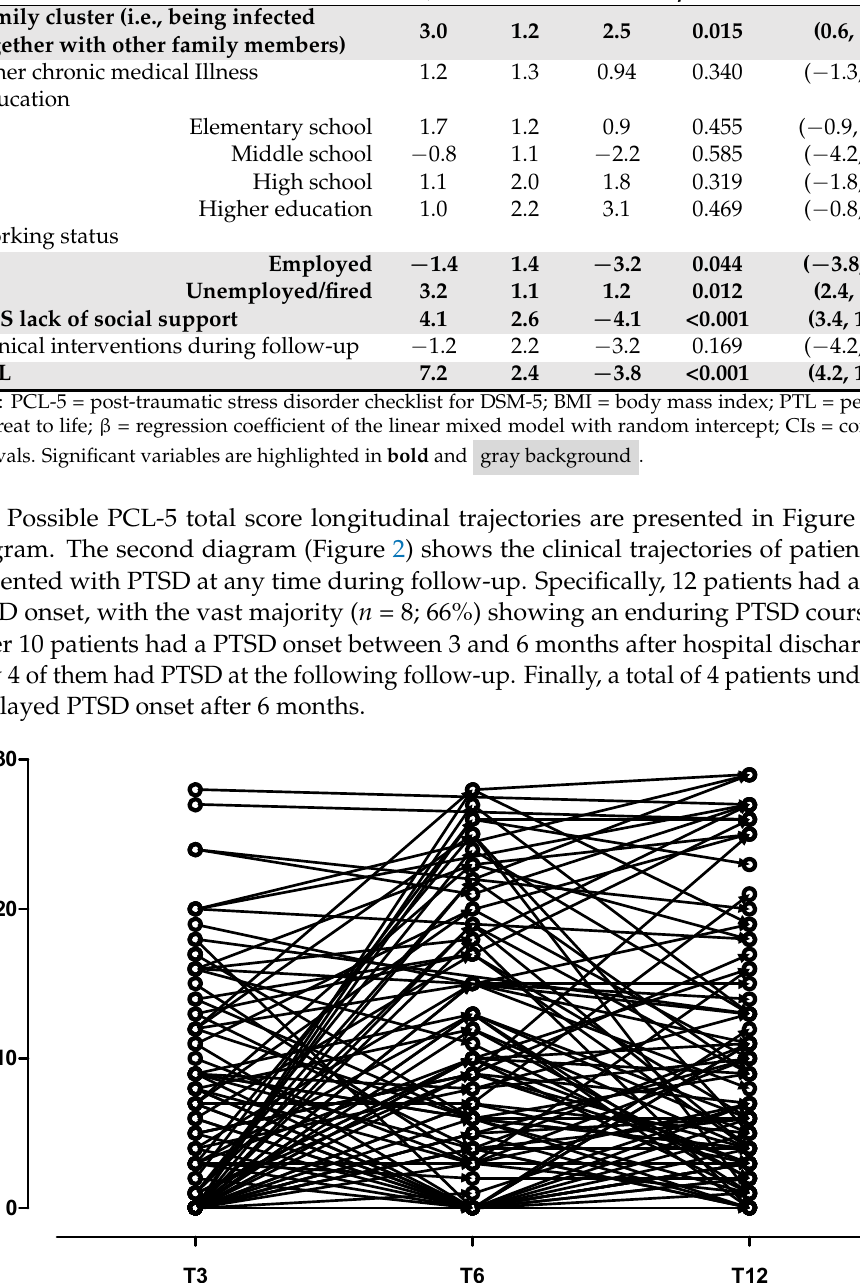
Figure 2. PCL-5 total score trajectories in patients with PTSD and the total amount of patients with PTSD at different follow-up assessments.